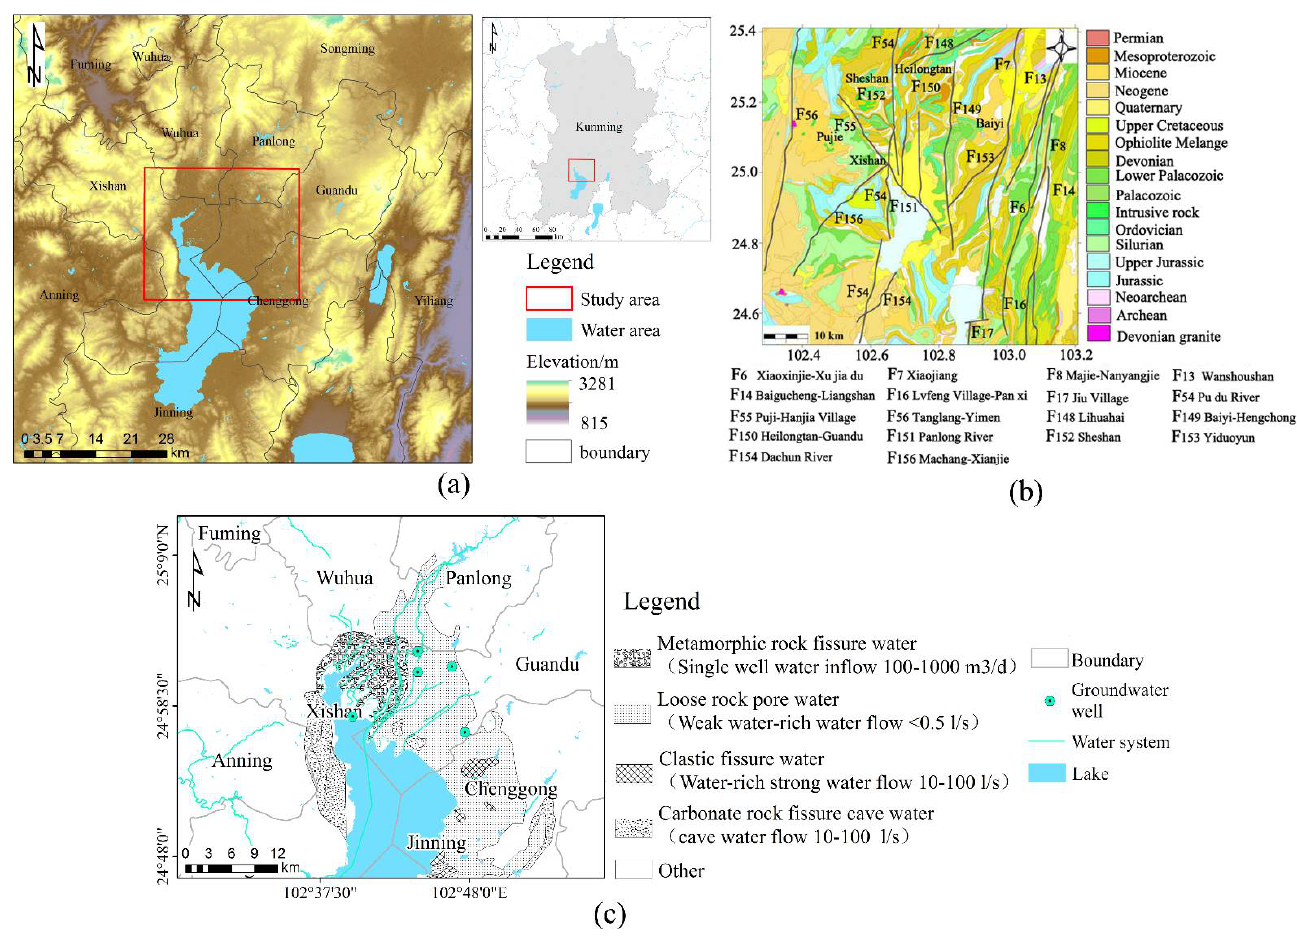
Figure 1. ( a ) is the location of the study area (the map in the upper-right corner shows the location of Kunming), and the corresponding data are superimposed on those of the National Aeronautics sion Laboratory (Jet Propulsion Laboratory, JPL), and the National Imagery and Mapping Agency (NIMA), who jointly surveyed and mapped the SRTM DEM data digital elevation model; ( b ) is a geological map of the study area. Black solid lines represent Quaternary active faults, The